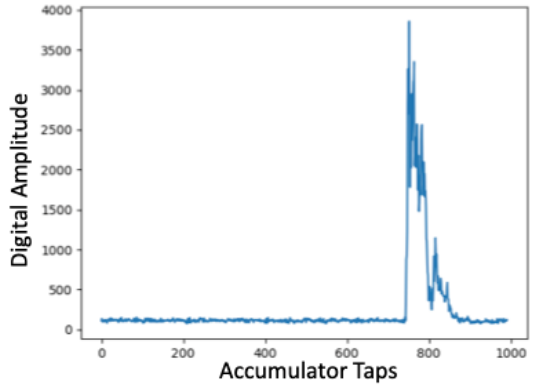
Figure 15. UWB Channel Impulse Response Window captured within the IPA Lab. The accumulator window captured multiple high magnitude peaks. These results indicate significant reflections within the space compared to the gym and Forrest Room translating into a high likelihood of reduced ranging and localization